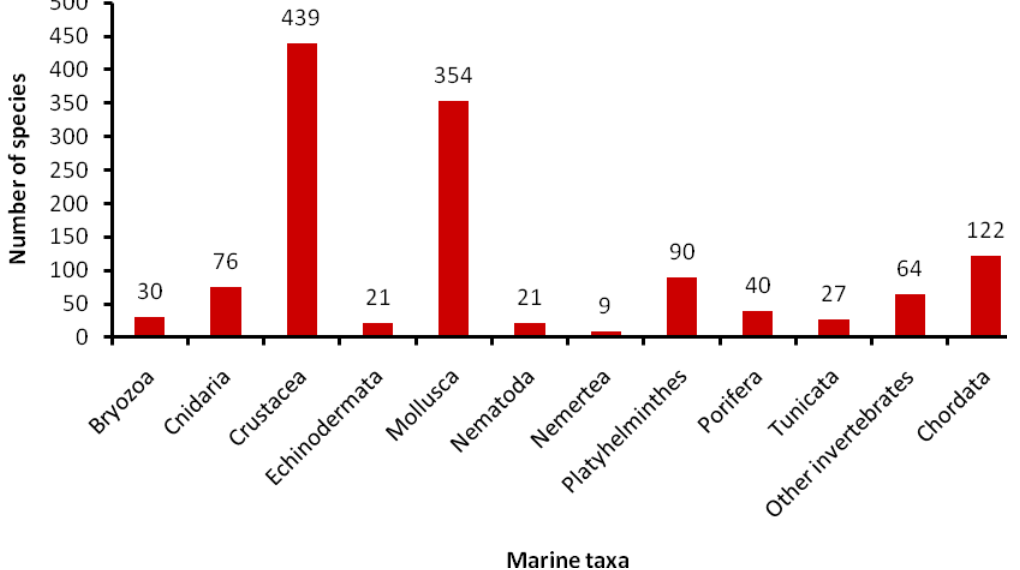
Figure 2. Average number of marine animal species per taxon described every year (modified from